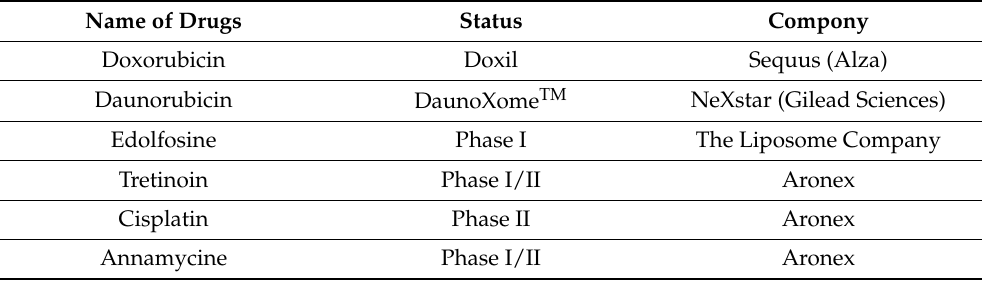
Table 2. Liposomal-based antiicancer drugs